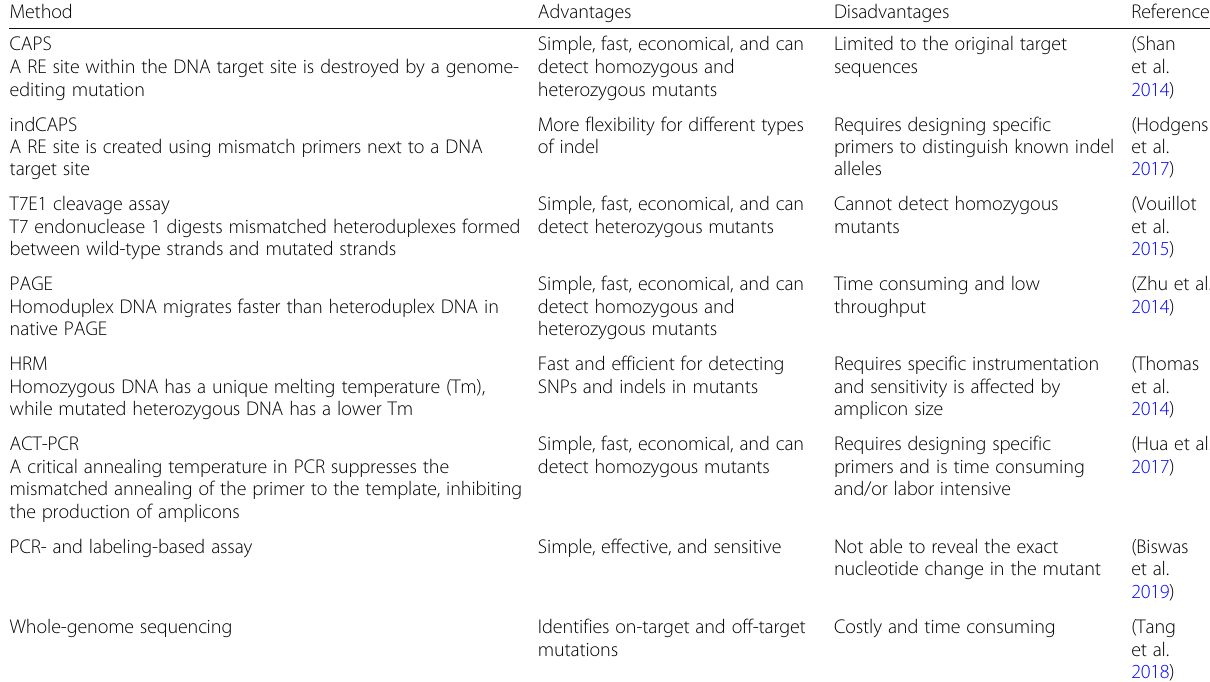
Table 2 Advantages and disadvantages of different methods for CRISPR/Cas9-mediated mutant screening. (Adapted from Bao et